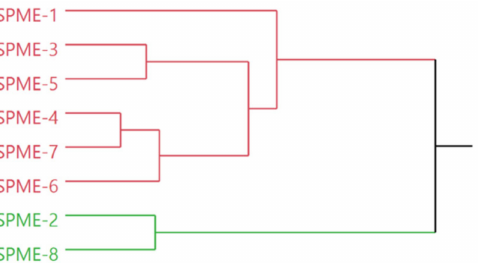
Figure 1. Dendrogram of the Rhus coriaria samples resulting from the HS-SPME analysis. Moreover, in this case, the samples were divided into two macro-clusters: the first one, highlighted in pink, contained six units, while the second one, evidenced in green contained only two sample, SPME-2 and SPME-8. The pink cluster, in turn, presented two internal groups, the first represented only by SPME-1 and the latter characterized by two sub-groups, one comprising SPME-3 and SPME-5, and the other SPME-4, SPME-7, and SPME-6. The SPME-2 sample was collected from Ajloun, Jordan which is located at higher altitude of ~1100 m than the other areas. Marketed samples 1, 3, 4, 5, and 8 were collected from the different commercial